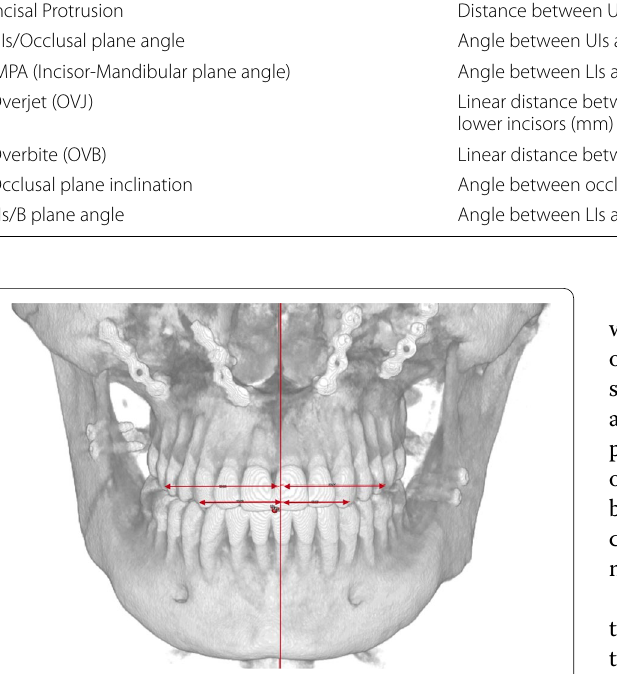
Fig. 7 View of a frontal dento-alveolar analysis in a PostOp case